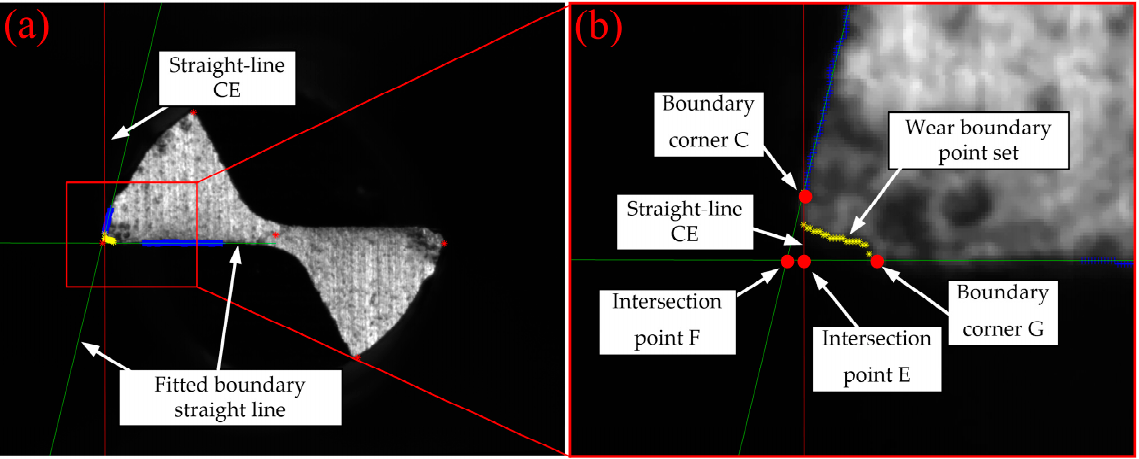
Figure 16. Wear extent extraction in rotated original tool wear image: ( a ) overall image for the wear extent extraction; ( b ) local detail image for the wear extent extraction.